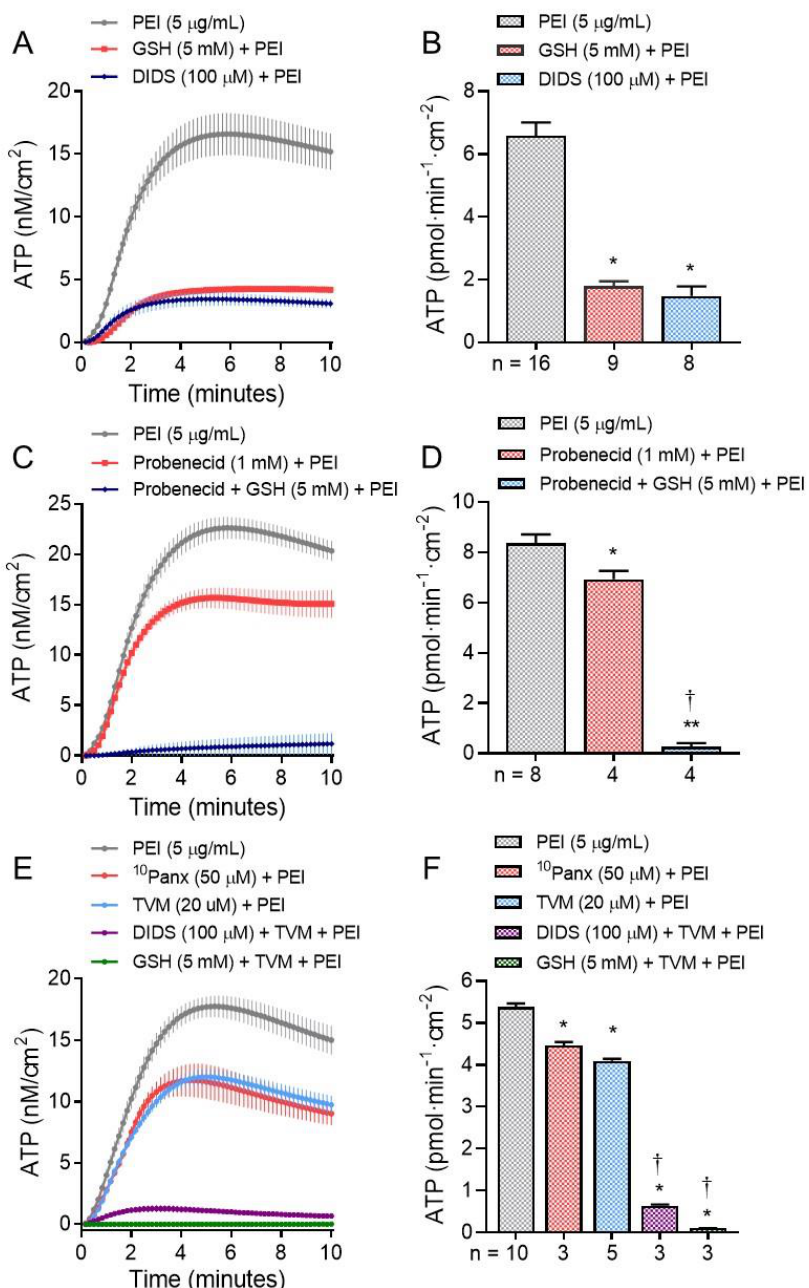
Figure 1. Effects of PEI on the kinetics of ATP release from hBE cells. ( A ). Time course measurements of ATP release following exposure to PEI (5 μg /mL) alone ( n = 16) or after pretreatment (1 h) with glutathione (GSH: 5 mM; n = 9) or DIDS (100 μM; n = 8). ( B ). Initial rates of ATP release measured between 0.5 and 2.0 min after exposure. Data points were fit using linear regression analysis (PEI alone, n = 16; GSH + PEI, n = 9; DIDS + PEI, n = 8, * p < 0.0001, ** p < 0.0264 compared to PEI alone; † p < 0.0001 comparing Probenecid + PEI with Probenecid + GSH + PEI). Initial rates of ATP release were determined from the slopes and plotted in the bar graph. GSH + PEI and DIDS + PEI conditions were significantly different from PEI alone; Brown-Forsythe and Welch ANOVA with Dunnett’s T3 posttest. ( C ). Effects of probenecid (1 mM) and probenecid + GSH (5 mM) on PEI-induced ATP release (PEI (5 μg /mL) alone, n = 8; Probenecid (1 mM) + PEI, n = 4; Probenecid + GSH (5 mM) + PEI, n = 4). ( D ). Initial rates of ATP release calculated from data generated in Figure 1C. Data points were fit using linear regression analysis (PEI (5 μg /mL) alone, n = 8; Probenecid (1 mM) + PEI, n = 4; Probenecid + GSH (5 mM) + PEI, n = 8). Initial rates of ATP release were determined from the slopes